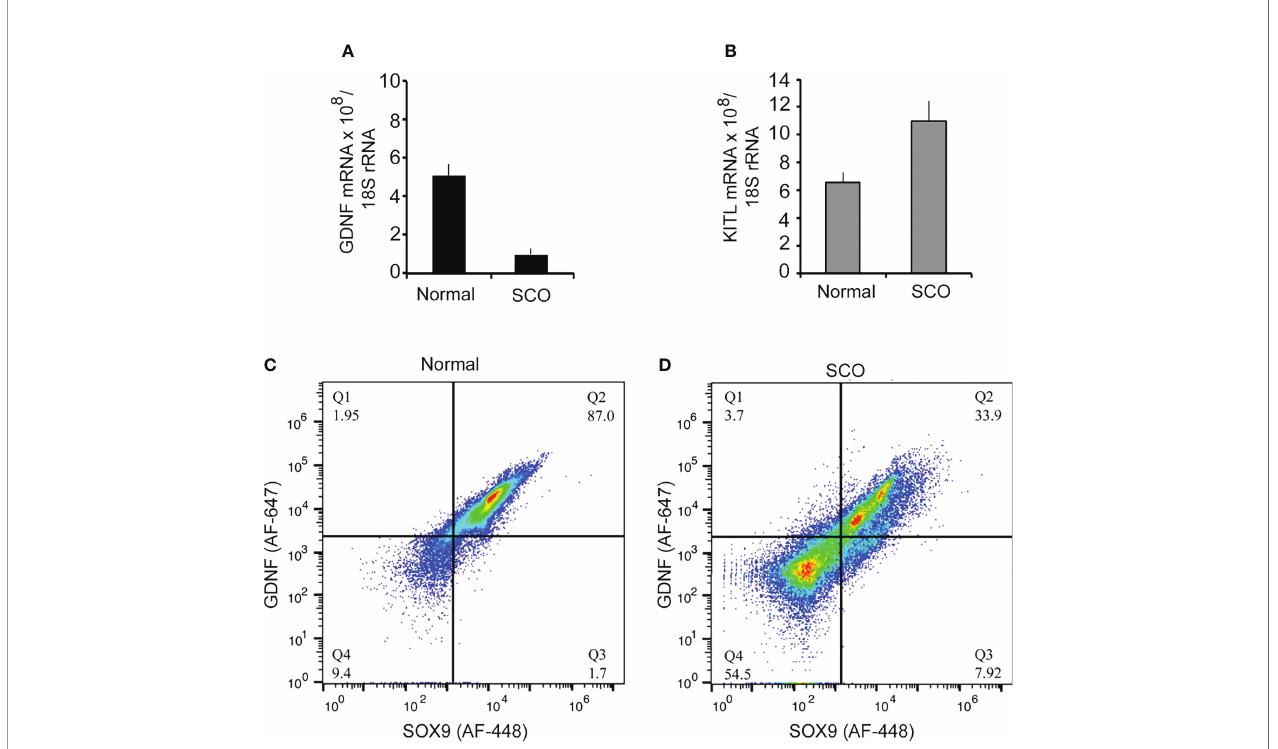
FIGURE 4 | A comparison of the expression of GDNF, and KITL by normal and SCO human testes. RNA was extracted from testis biopsies and expression of GDNF mRNA (A) , and KITL mRNA (B) assayed by real-time PCR. Data were normalized for b actin mRNA in each sample. GDNF mRNA expression was 5.2-fold higher in normal testes than in SCO testes, while KITL mRNA expression was 1.7-fold higher in SCO testes than in normal testes. (C, D) Fluorescence-activated cell sorting was used to determine if human Sertoli cells express GDNF and if this expression is signi fi cantly reduced in SCO testes. Single cell suspensions were prepared from biopsies of human normal (C) and SCO testes (D) and cells incubated with fl uorochrome-labeled antibodies for GDNF and the human Sertoli cell speci fi c marker, SOX-9 (23). Data are presented as relative amounts of GDNF and of SOX 9 in each cell. Results, which are representative of 5 independent experiments, demonstrate that normal testes contain a single GDNF-expressing population of Sertoli cells. However, SCO testes contain two populations of Sertoli cells, and the predominant population contains less GDNF than cells in normal testes. Results are from: